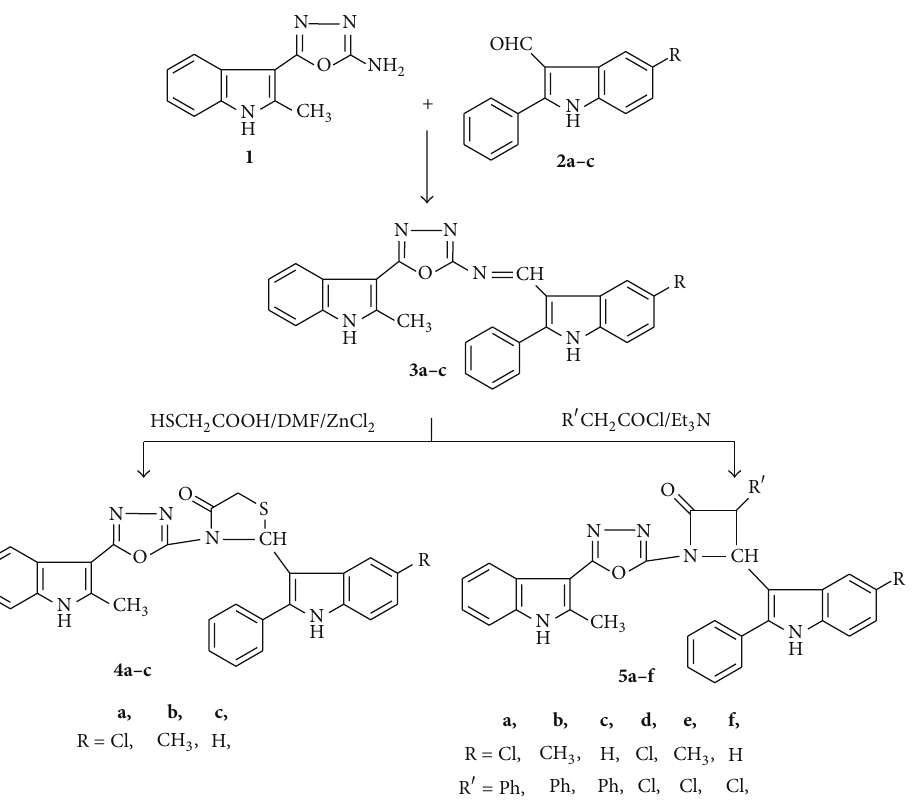
Scheme 1: Schematic pathway for the synthesis of title